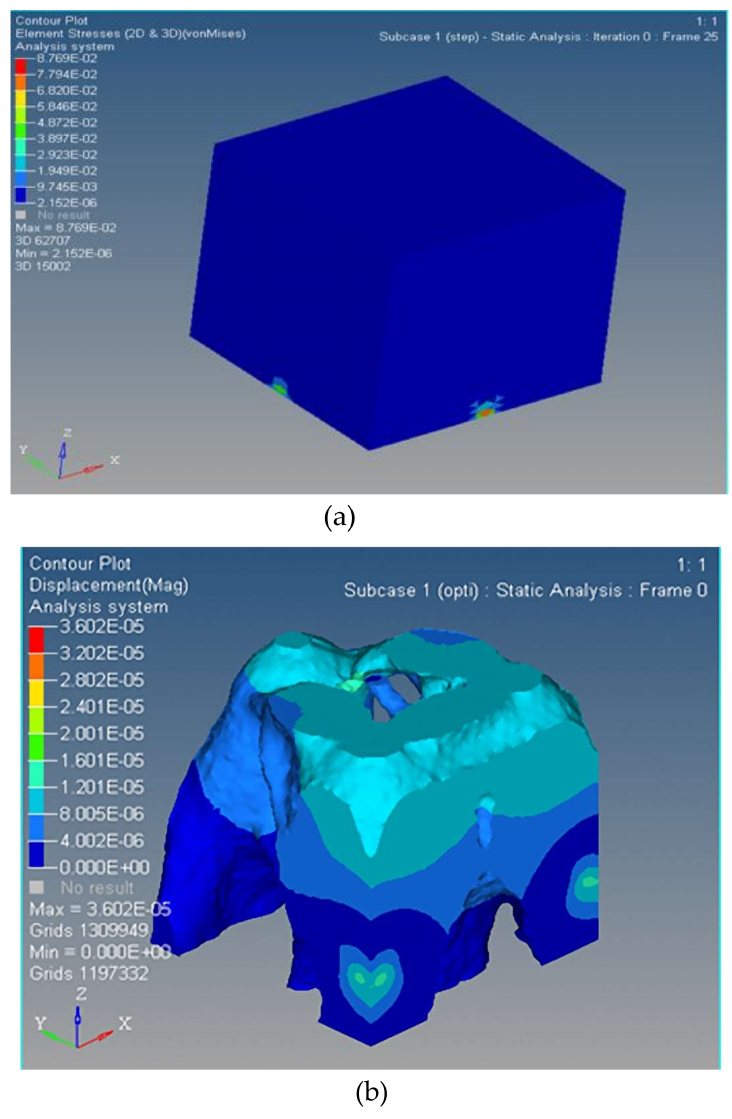
Figure 7. Stress distribution comparison: ( a ) before optimization; ( b ) after